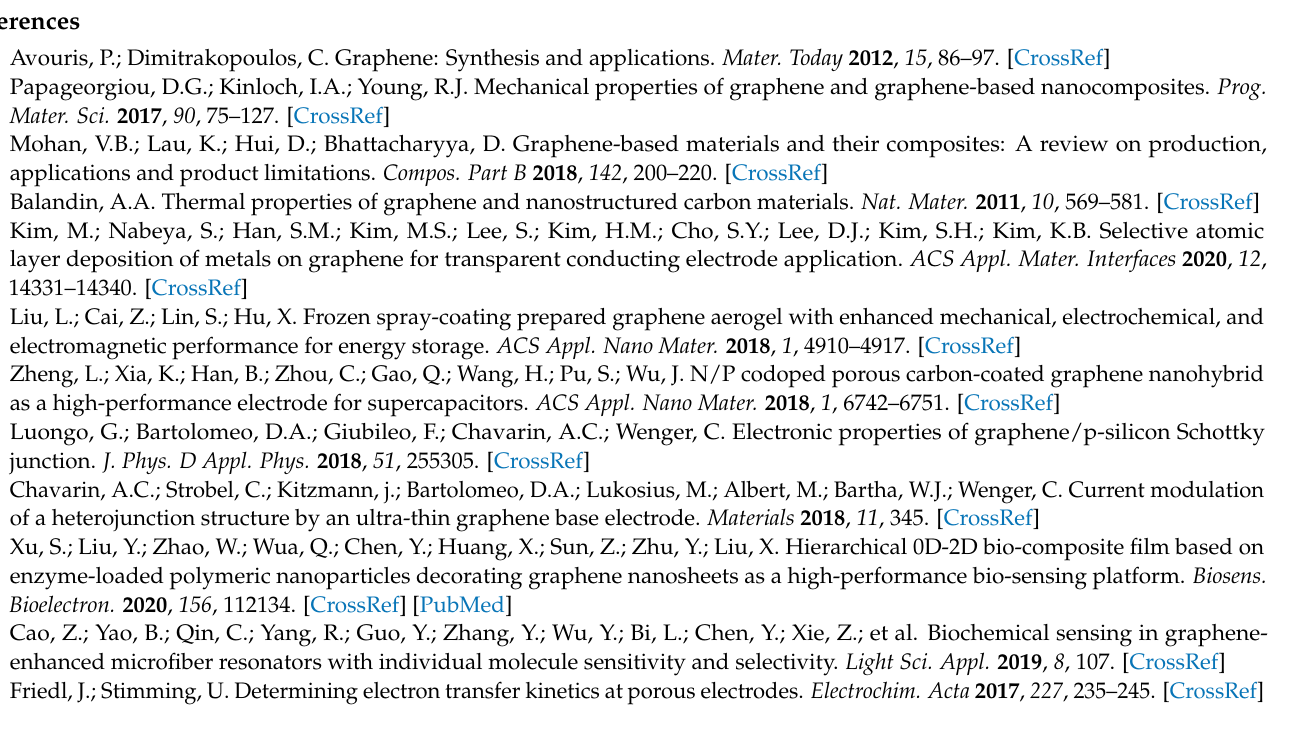
fabrication procedure of the GM electrode, (b) The cross-section view of the electrode; Figure S3: (a) Optical microscopic image and (b) AFM profile of representative cracks of the TiO 2 template V-50; Figure S4: (a) SEM image of the Ni mesh obtained with the TiO 2 template V-50, (b) AFM profile of the NM V-50; Figure S5: The SEM images of several random positions of the Ni mesh (NM V-50) sample obtained from the TiO 2 template V-50; Figure S6: The intensity ratio of D/G peak vs. surface coverage of graphene wires of each GM electrode; Figure S7: Representative cyclic voltammograms of graphene electrodes with different SC of graphene wire in 1 mM ferrocene and 0.1 M Bu 4 NPF 6 in acetonitrile electrolyte obtained at a scan rate of 0.02 V/s; Figure S8: Planar graphene (a) OM image, (b) Raman shift spectrum; Figure S9: Anodic peak position vs. log(scan rate); Figure S10: CV of (a) the hybrid mesh V-5 and (b) V-50 electrodes in 0.1 M NaOH with/without glucose; Figure S11: SEM image of the graphene/Ni hybrid mesh V-50; (b) EDS analysis of the graphene/Ni hybrid mesh; Figure S12: Selectivity of the graphene/Ni hybrid mesh V-50 measured with 1 mM glucose, 0.1 mM AA, 0.1 mM DA, 0.1 mM UA and 0.5 mM glucose in 0.1 M NaOH. Table S1: Average width and average edge length of graphene wire, Table S2: The transfer coefficients ( α ) between electroactive compound and the graphene